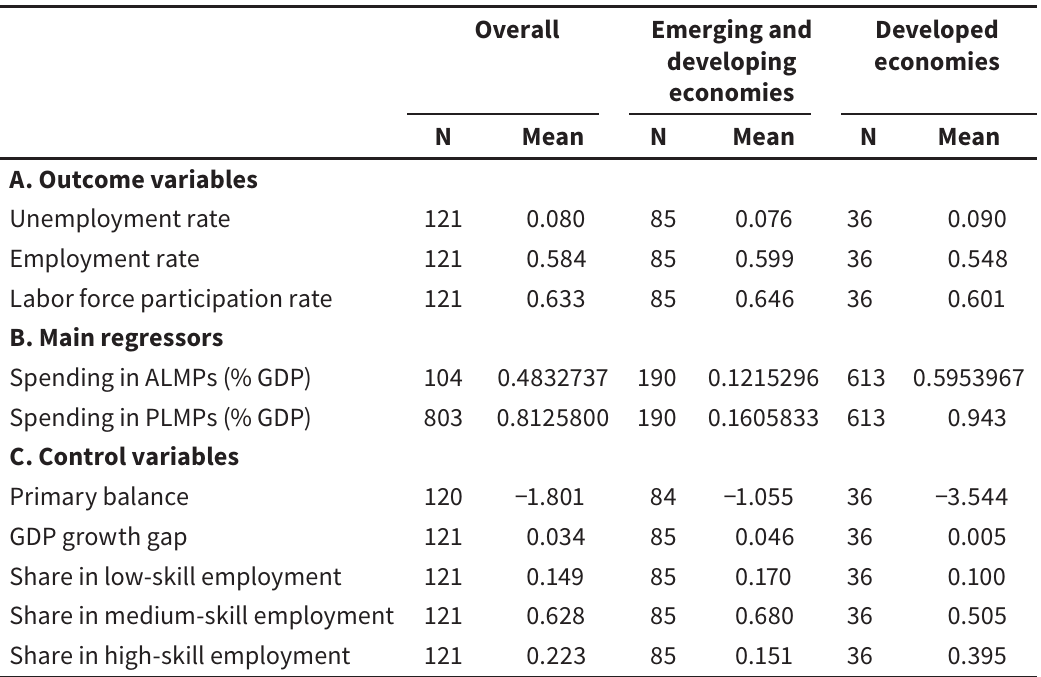
Table 1. Descriptive statistics (2010)